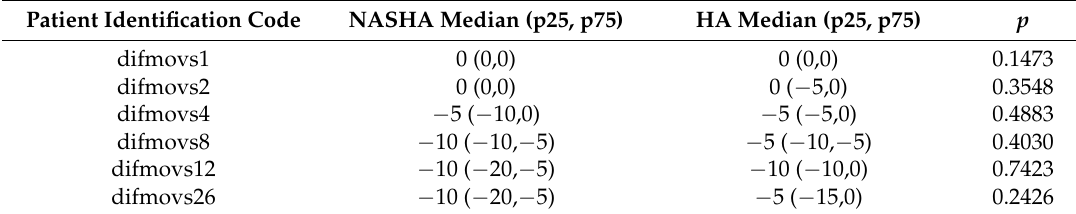
Table 5. Mobility assessment in patients treated with NASHA versus HA